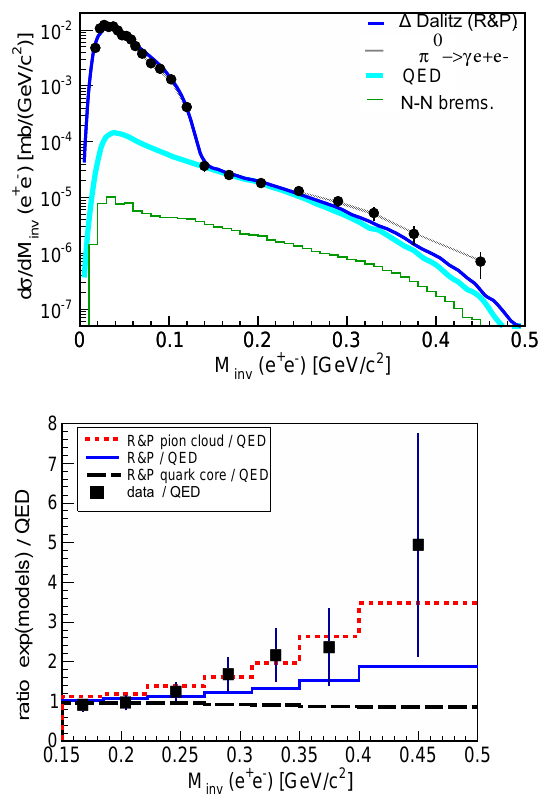
Figure 6. Upper: Dielectron invariant mass distribution from p + = 1 . 25 GeV compared to calculations using p collisions at E kin the Δ (model of Ramahlo and Pena (R&P)-blue [23] and for the point-like Δ (QED-cyan), π 0 Dalitz and p + p bremsstrahlung. Bottom: Ratio of the measured dielectron invariant mass from the Δ (1232) → pe + e − decay to the model of point-like particle (QED) compared to the Ramahlo and Pena (R&P) full model (blue) and assuming dominance of the photon-quark core (black dashed) and photon-pion-cloud contributions (red dashed) (see text and [21] for